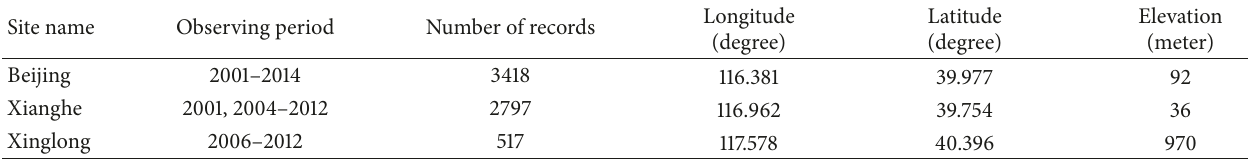
Figure 1: Geographical location of the selected three AERONET sites. Table 1: Information of the selected three AERONET